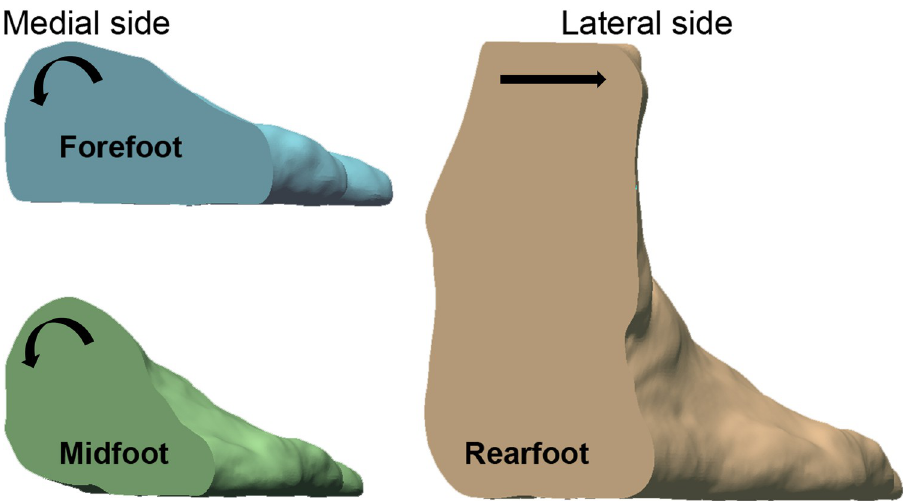
Fig 7. Rotation of the right foot in a cross section of the foot from NWB to HWB and 80%WB.